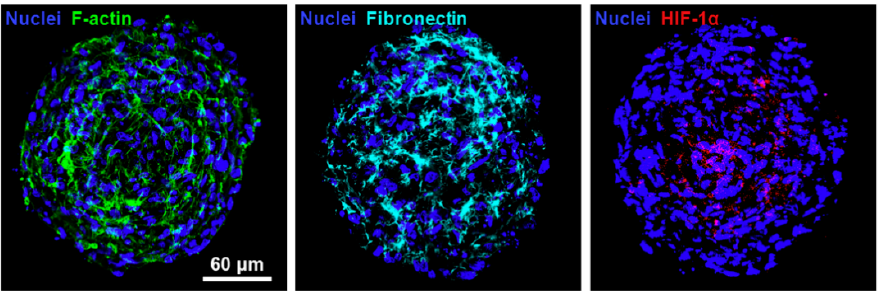
Figure 11. Immunofluorescence images of human umbilical vein endothelial cells (HUVEC)/cbMSC cell spheroids stained with antibodies against F-actin, fibronectin, and hypoxiainducible factors (HIF-1 α ). The results indicate that cell spheroids possessed the ECM molecule fibronectin and hypoxiaresponsive transcription factor HIF-1 α . (Reproduced from Reference [112]).